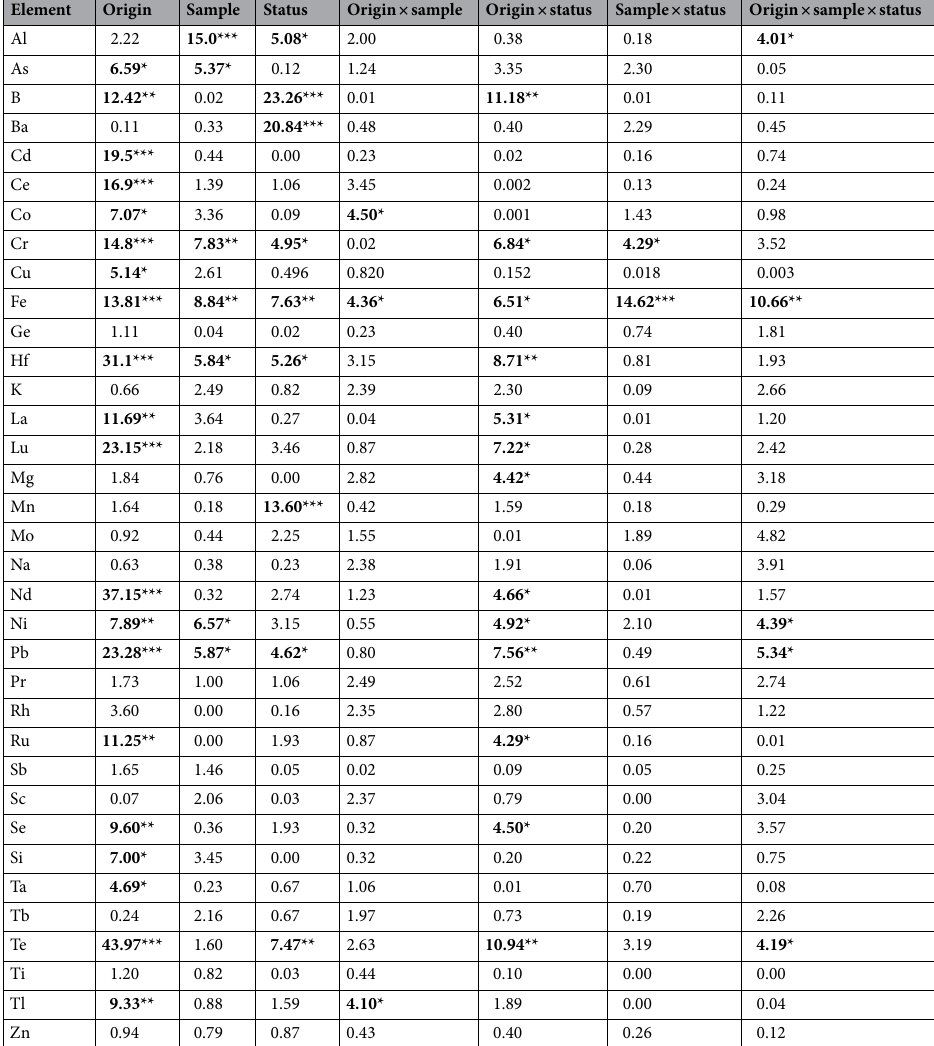
Table 2. F -values and the accompanying significance levels from three-way full factorial ANOVA performed to test the effect of the origin of eggs (from wild vs. Captive hens), sample (= eggshell region—background vs. spot), egg status (non-embryonated eggs vs. post-hatched eggshells) and the interaction terms between them on ICP-OES-based eggshell elemental profiles in Black Grouse Tetrao tetrix . Statistically significant effects are in bold. The elemental concentrations corresponding to the tested effects are listed in Table S3. * P < 0.05; ** P < 0.01; *** P <